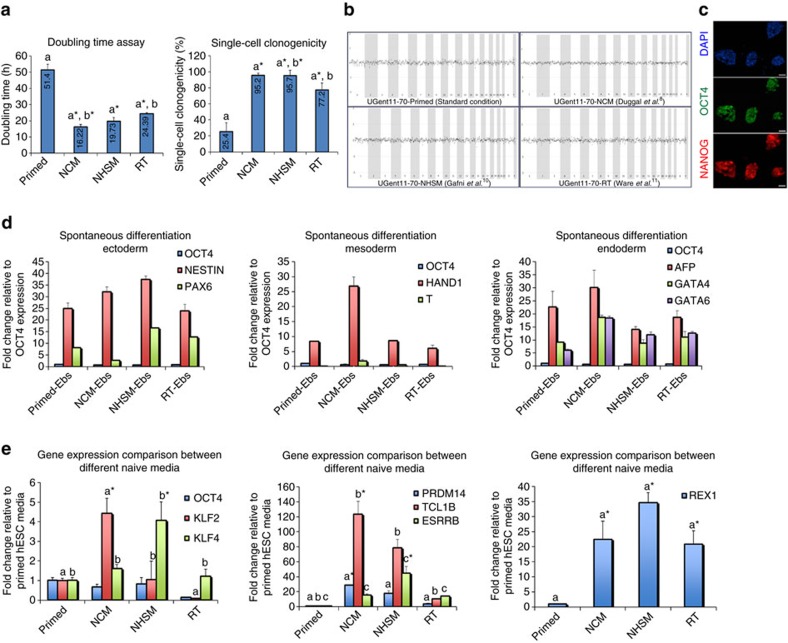
Assessment of naive pluripotency in the newly formed naive hESCs from primed hESC line UGent11-70.(a) Doubling time and single-cell clonogenicity assays for primed hESCs, NCM-, NHSM- and RT-naive hESCs. a* compared to a and b* compared to b, *P<0.05. (b) Depiction of chromosomal analysis for primed hESCs, NCM-, NHSM- and RT-naive hESCs via array comparative genome hybridization (aCGH). (c) Representative immunofluorescence image for pluripotency makers OCT4 and NANOG in NCM-, NHSM- and RT-naive hESCs; Scale bars, 200 μm. (d) qRT-PCR analysis for ectoderm, mesoderm and endoderm markers on spontaneously differentiated primed hESCs, NCM-, NHSM- and RT-naive hESCs as EBs for 14 days. (e) Gene expression analysis for naive-pluripotency specific genes on undifferentiated primed hESCs, NCM-, NHSM- and RT-naive hESCs. a* compared to a and b* compared to b, *P<0.05. The data are represented as mean±s.d.